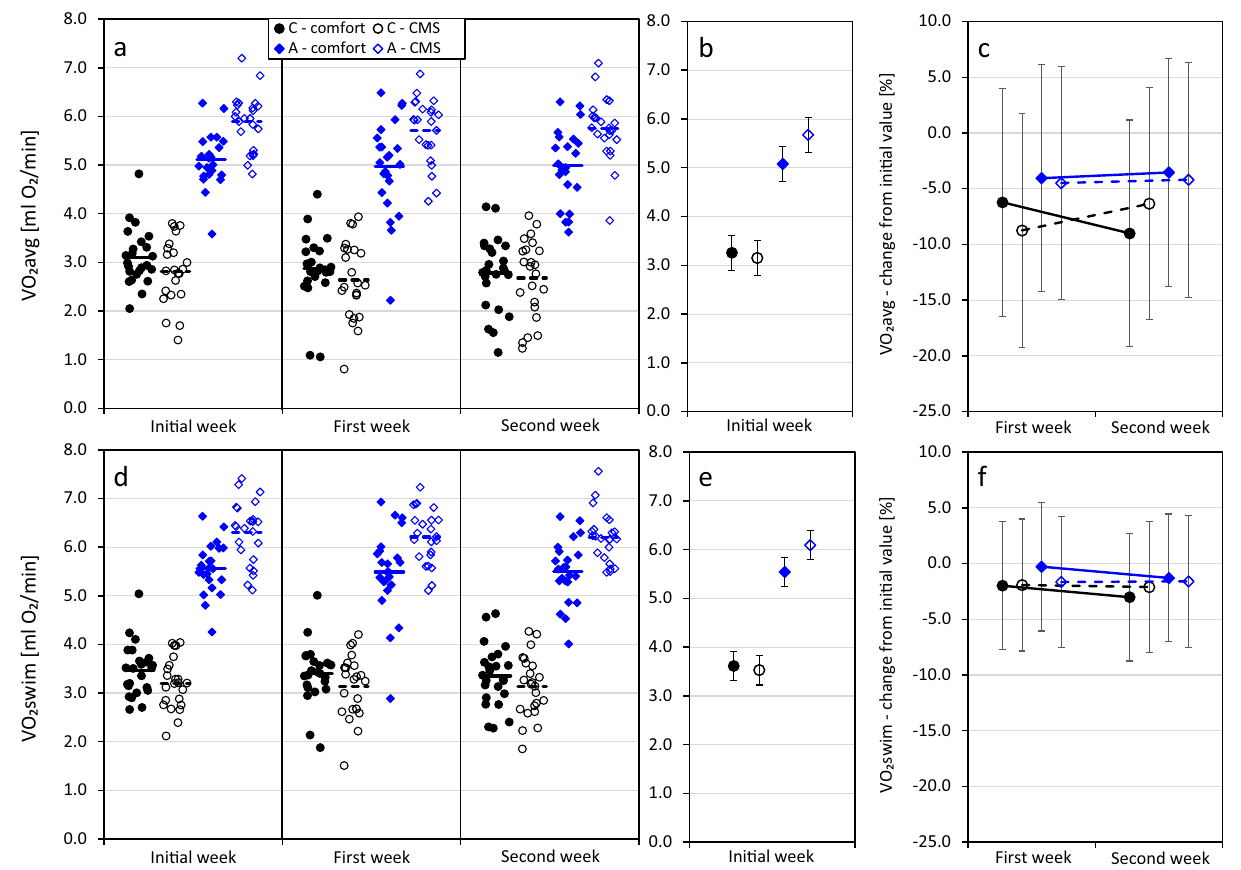
Figure 4. The effects of selection and chronic mild stress (CMS) on bank vole average and maximum swim- induced rate of oxygen consumption (VO 2 avg and VO 2 swim) measured before (Initial week), during (First week), and after (Second week) the experiment. The experiment was performed on 48 C-line (“control”) and 46 A-line (“aerobic”) voles. Left column – raw data with group means, middle and right columns—least squares means ± 95% confidence intervals of trait values calculated for an average (22.4 g) body mass. Results of the experimental treatment (right column) are represented as % change relative to the initial-week